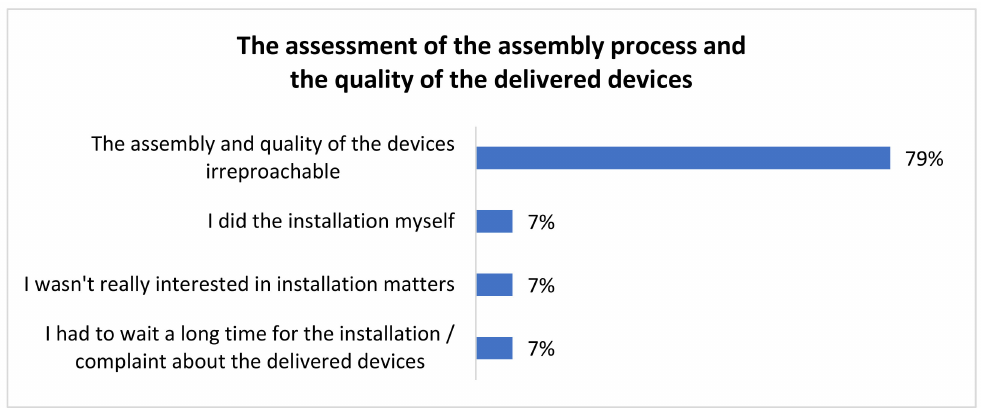
Figure 4. Answers to questions about the evaluation of PV assembly ( n = 57). Source: own study.